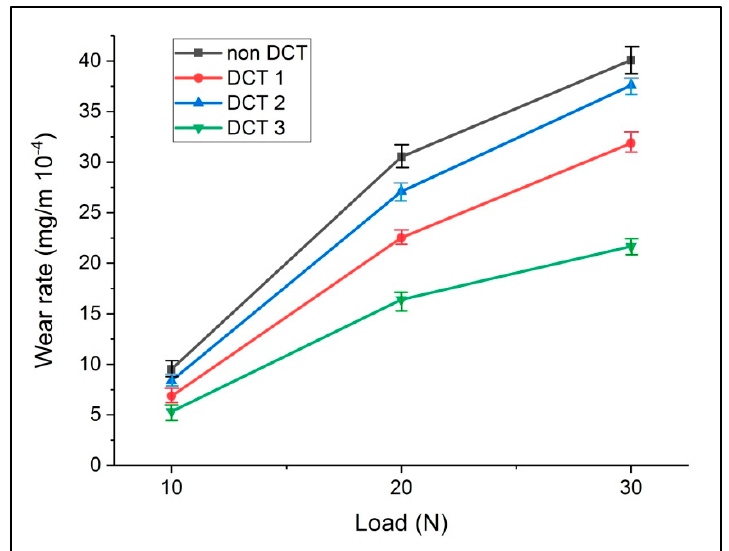
Figure 2. Wear rate data with varying loads of all four samples.